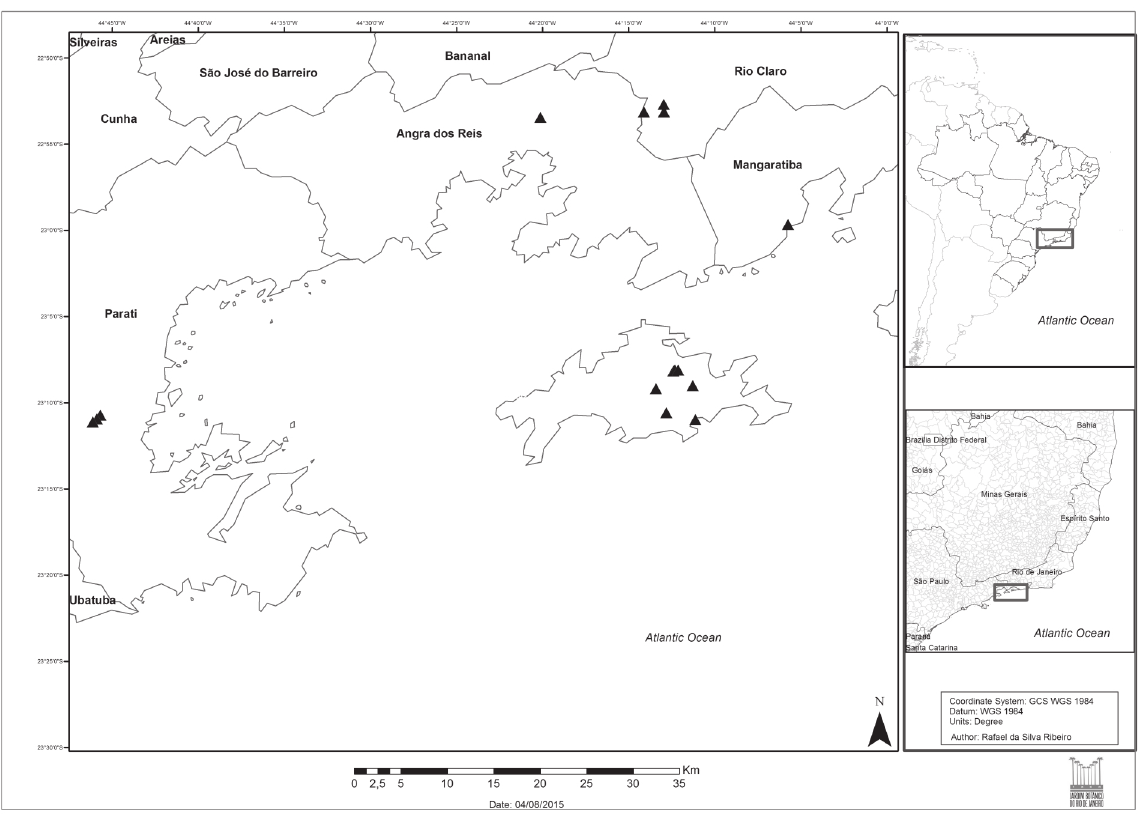
Figure 3 - Distribution map of Miconia gigantea Cogn., endemic to Rio de Janeiro, southeastern Brazil, with the localities of the occurrence the